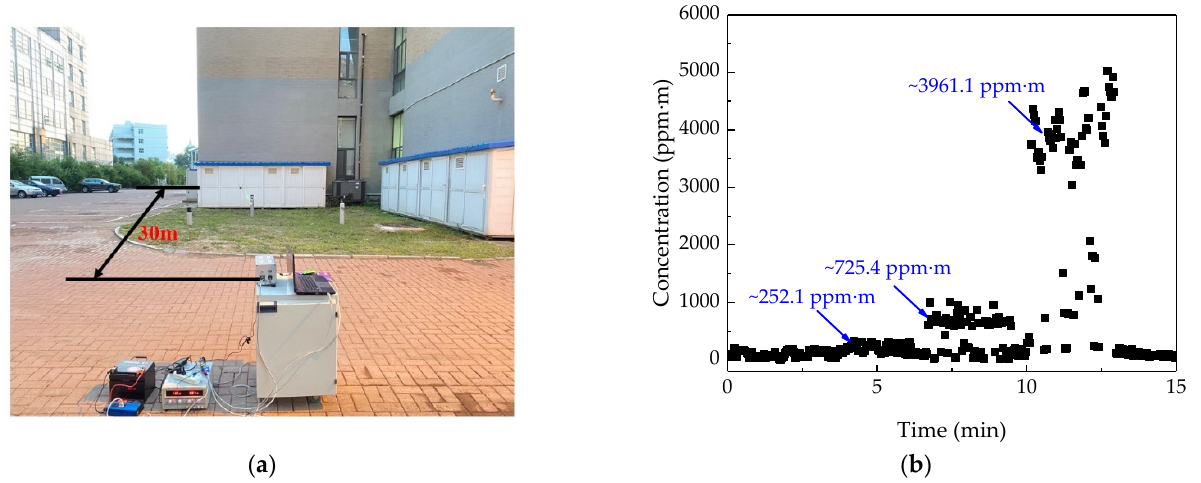
Figure 8. ( a ) The outdoor experiment where NH 3 gas cylinders were set at a distance of 25 m to simulate industrial NH 3 leakage; the concentration order from right to left is 2000 ppm, 10,000 ppm, 50,000 ppm; and the distance from target is 30 m. ( b ) The integral concentration of NH 3 at the three leakage ports obtained by the NH 3 remote sensor system based on the test conditions shown in ( a ).